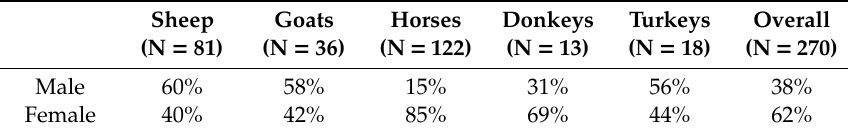
Table 4. Gender of respondents (%) for each species included in the survey (N =